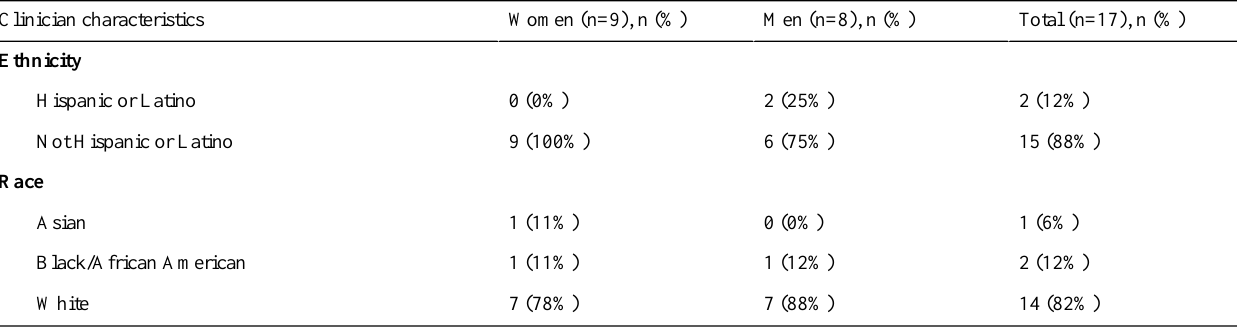
Table 1. Focus group participant (clinician) characteristics